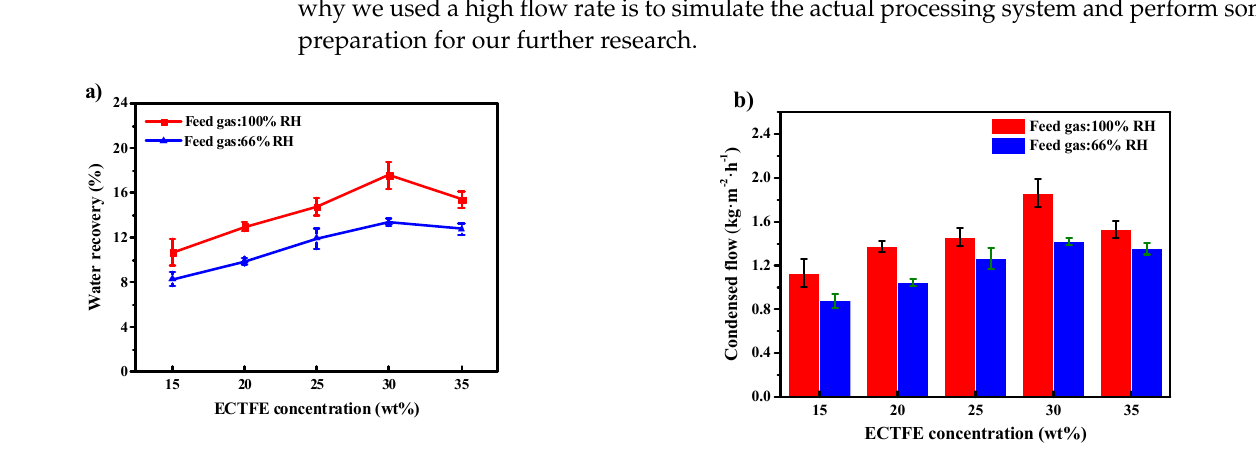
Figure 7. ( a ) Water recovery and ( b ) condensate yield of ECTFE membranes prepared with different polymer concentrations.